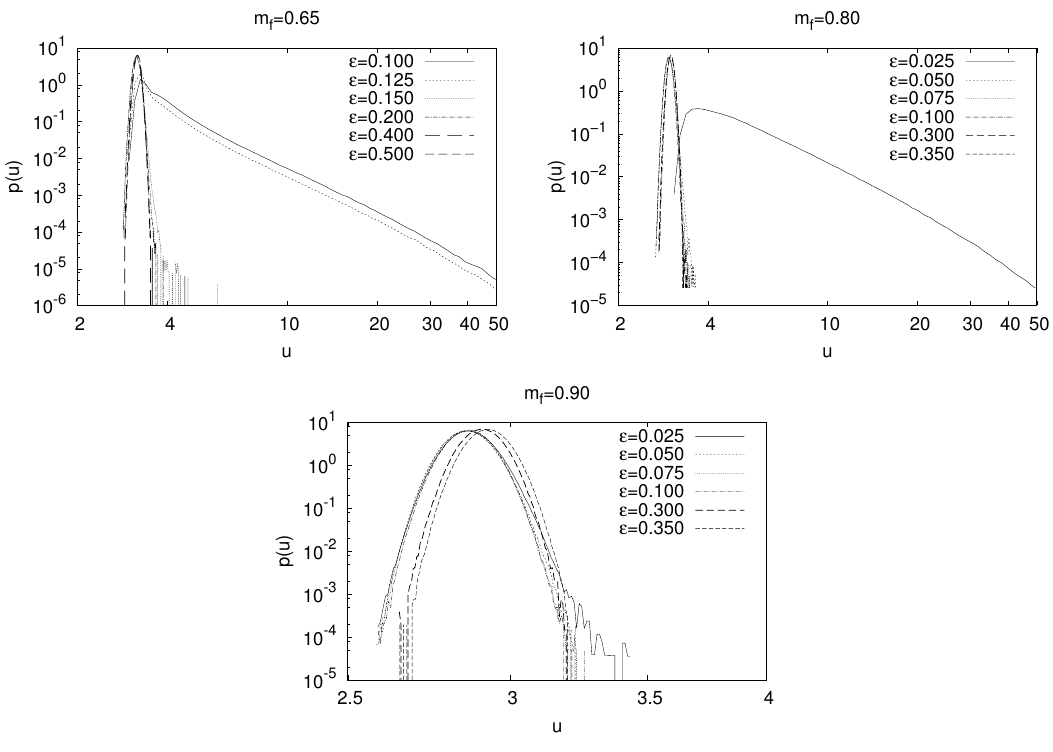
Figure 1 . The probability distribution p ( u ) of the magnitude of the drift term u de(cid:12)ned by eq. (3.9) is plotted for N = 24 with m f = 0 : 65 (Top-Left), m f = 0 : 80 (Top-Right) and m f = 0 : 90 (Bottom).